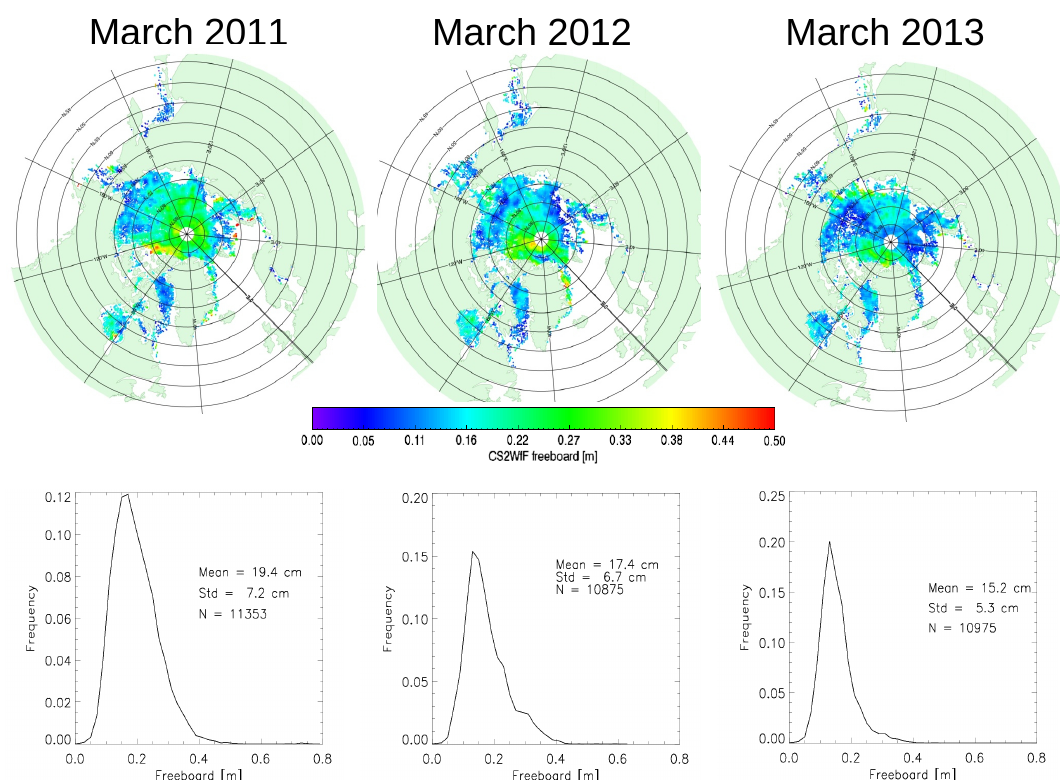
Figure 9. Gridded freeboard retrievals from the CryoSat-2 CS2WfF method and their distributions.